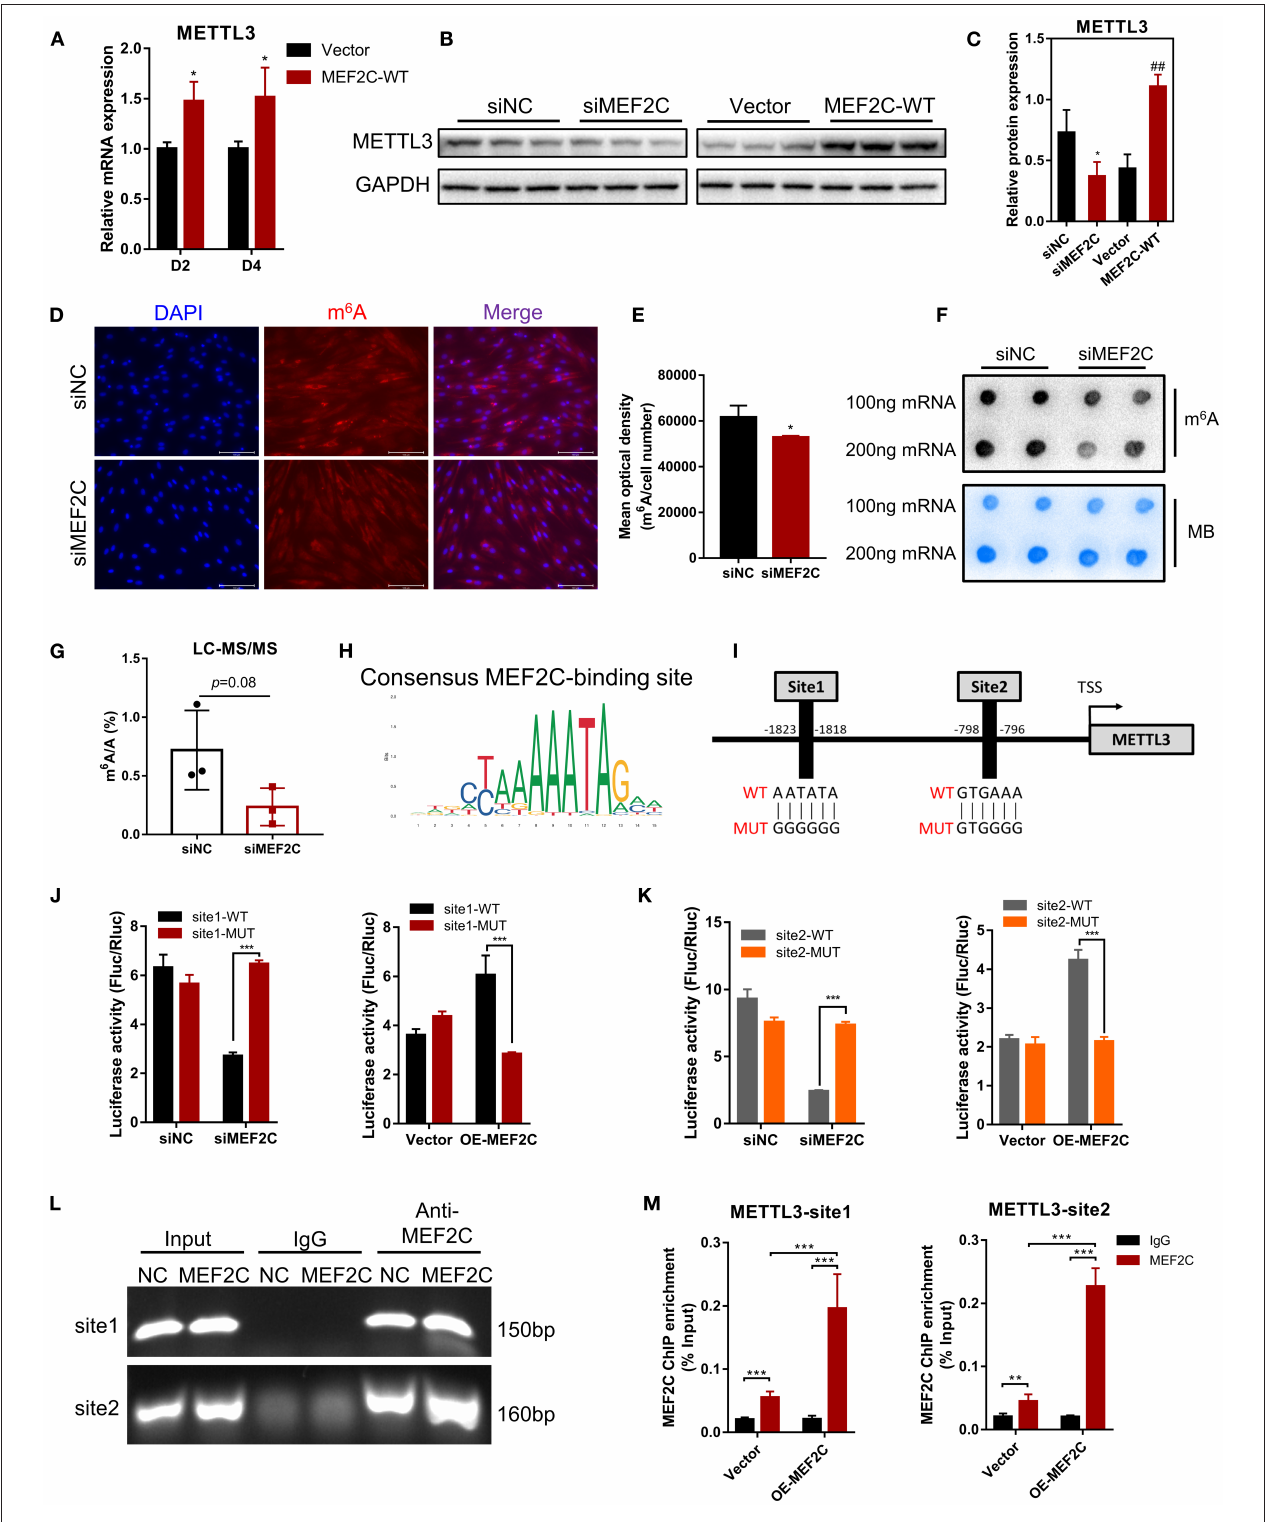
FIGURE 6 | Protein expression of METTL3 is regulated by MEF2C via direct DNA-binding. (A) Overexpression of MEF2C promotes the expression of METTL3 mRNA on the 2nd and 4th days after differentiation. (B,C) METTL3 protein levels after MEF2C knockdown and overexpression on the 4th day after differentiation. * p <